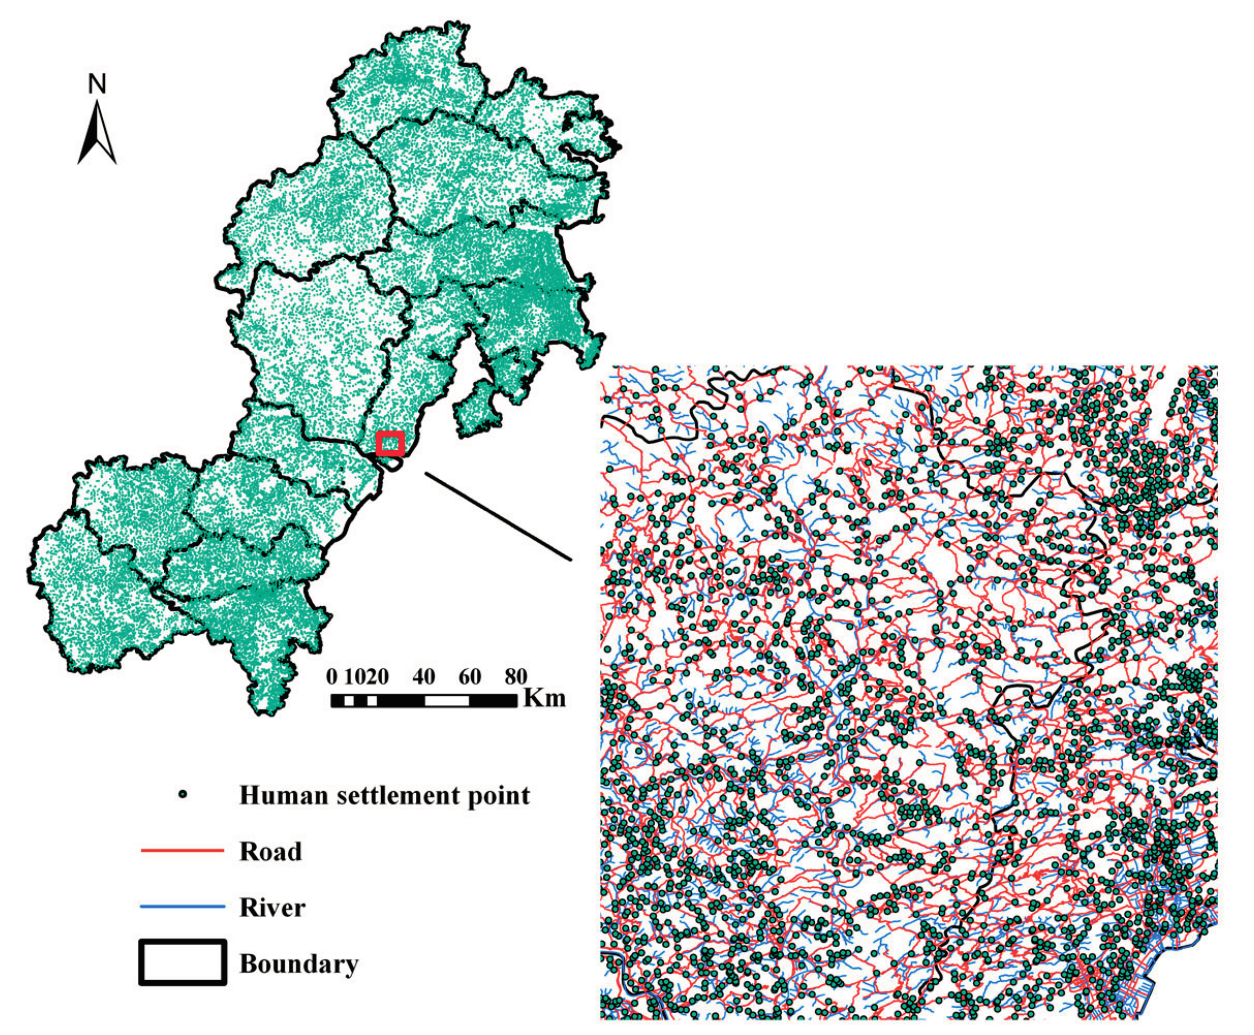
Figure 2. Spatial patterns of settlement locations, roads, and rivers across the Wen-Tai region,